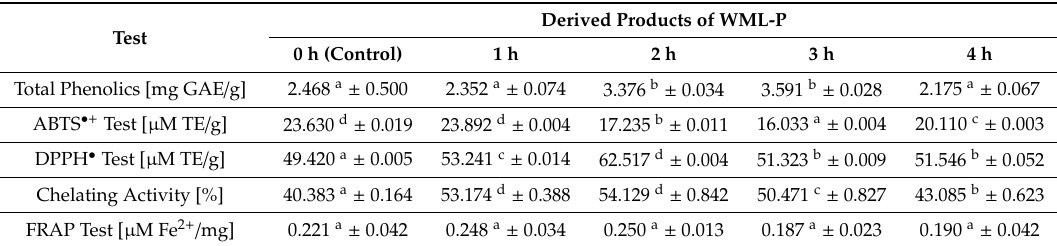
Table 2. Antioxidant activity of dried Polish var. zolwinska wielkolistna leaves (WML-P) before (control) and after conditioning. Derived Products of WML-P Test 0 h (Control) 1 h 2 h Total Phenolics [mg GAE /